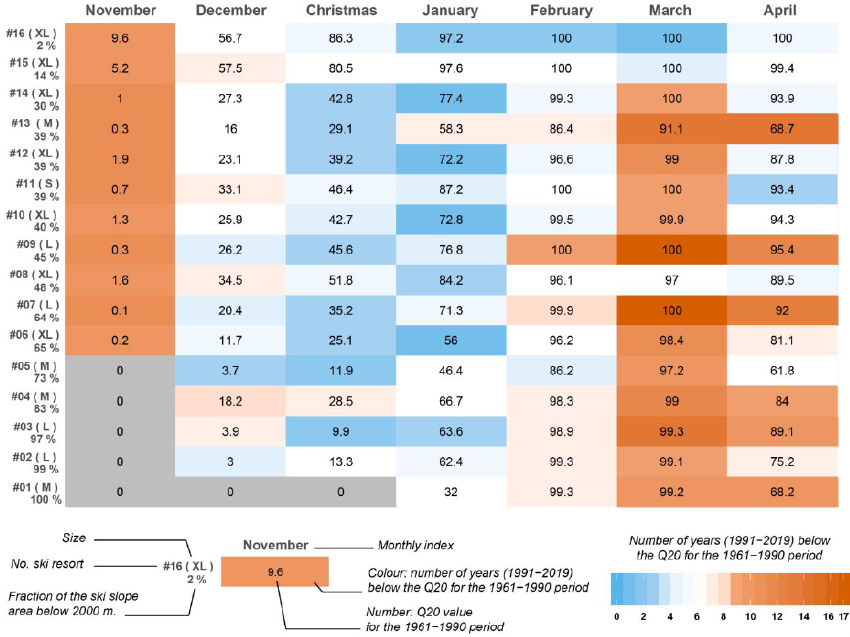
Table 2. Frequency of occurrence of monthly snow reliability challenging conditions, between 1991 and 2019, below the reference Q 20 value for the time period 1961–1990, without snowmaking throughout the entire time period. Each row corresponds to a ski resort (ranked as a function of the increasing fraction of the domain below 2000m). Each column corresponds to a monthly reliability indicator. The values in the matrix correspond to the Q 20 reference snow reliability indicator. Red and orange cells correspond to larger frequencies during 1991–2019 than during the reference time period (more often challenging conditions) and vice versa in blue.